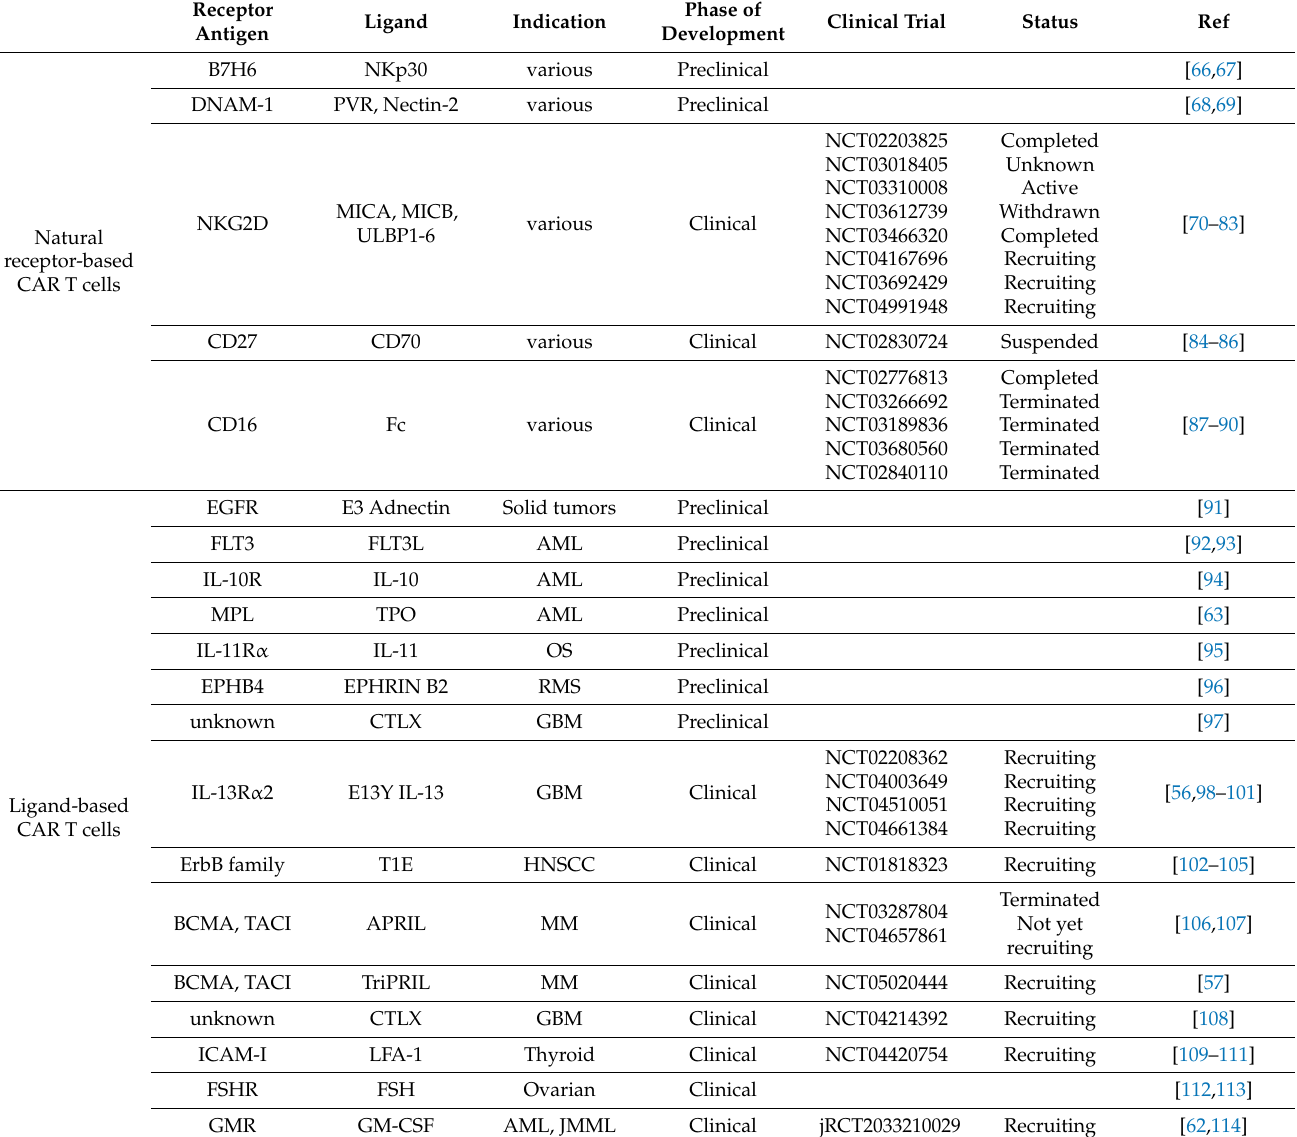
Table 1. Natural receptor- and ligand-based CARs are currently in preclinical and clinical development. Receptor